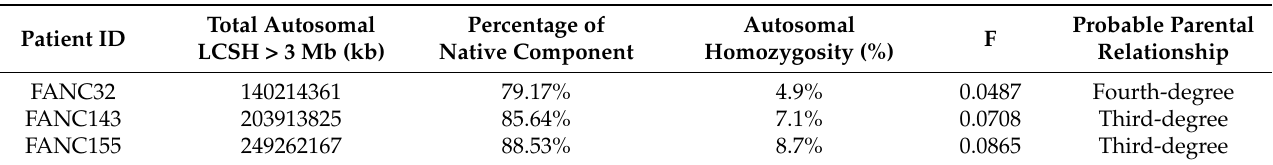
Table 2. Native component, homozygosity, and coefficient of inbreeding in the three Mixe patients with Fanconi